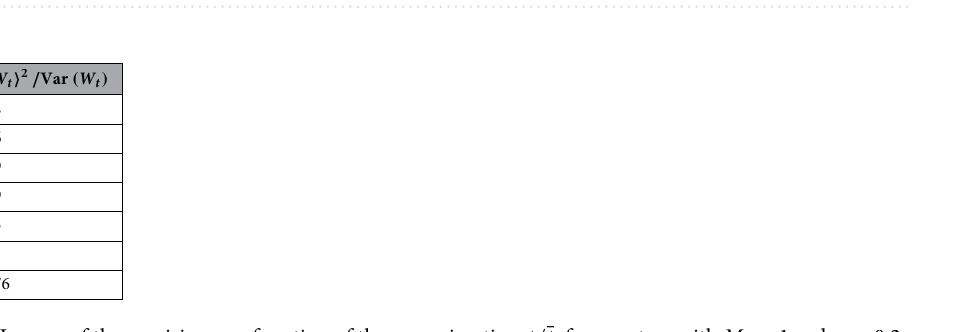
Figure 7. Work distribution at fixed porosity. ( a ) Pdf of the work performed by the engine on the load mass during a time window t = 40 ¯ t c for systems with p = 0.2 and several values of M l . ( b ) Logarithm of the local minima of the curves shown in ( a ). Inset: Variance of the distribution computed from a Gaussian fit to the data around its maximum (squares) and from the numerical computation using all the work data (circles).